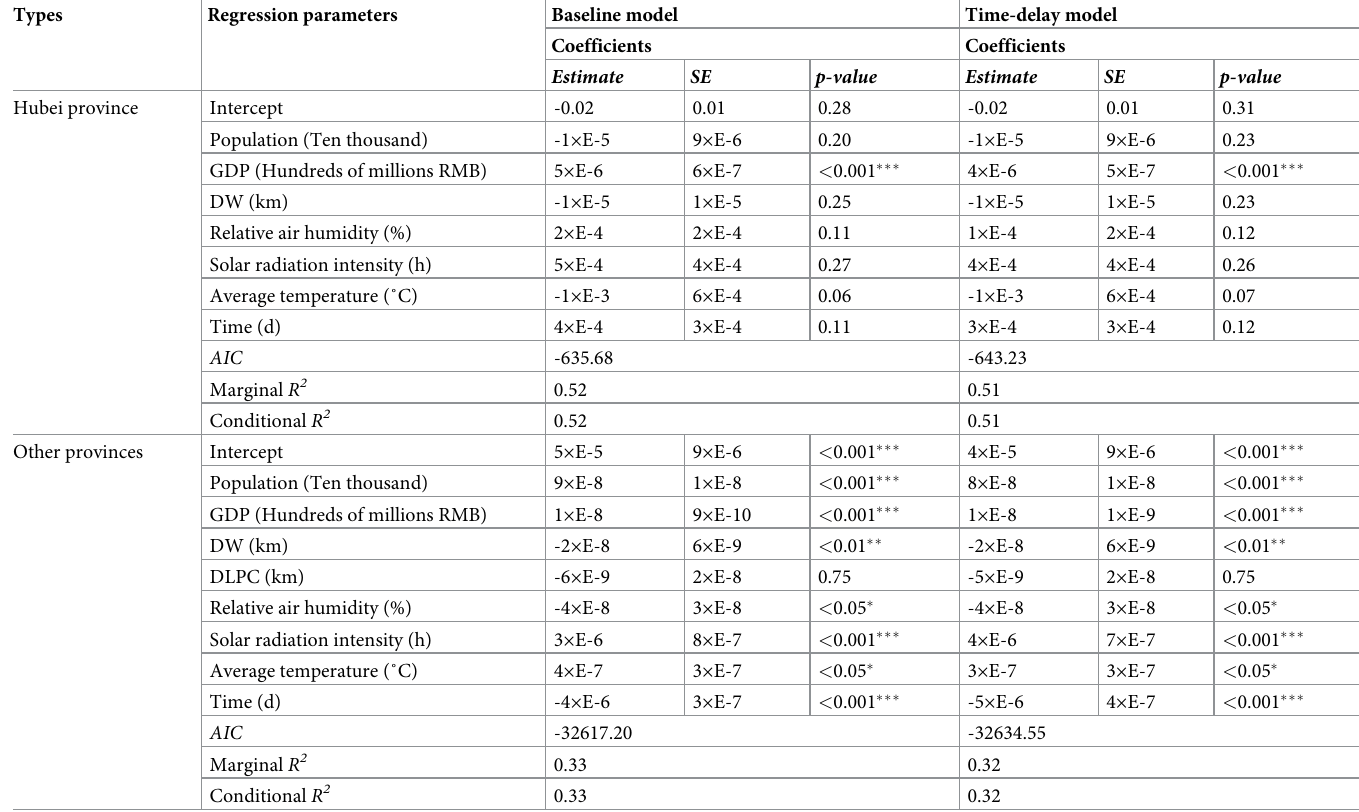
Table 4. Results of GLMs in relationship of the confirmed cases over population size per 100000 at every 5 consecutive days (CCOPSPTT) with socio-economic determinants (GDP and population), spatial distance (DW and DLPC), climate factors (relative air humidity, solar radiation intensity and average temperature) and time in cities outside and within Hubei